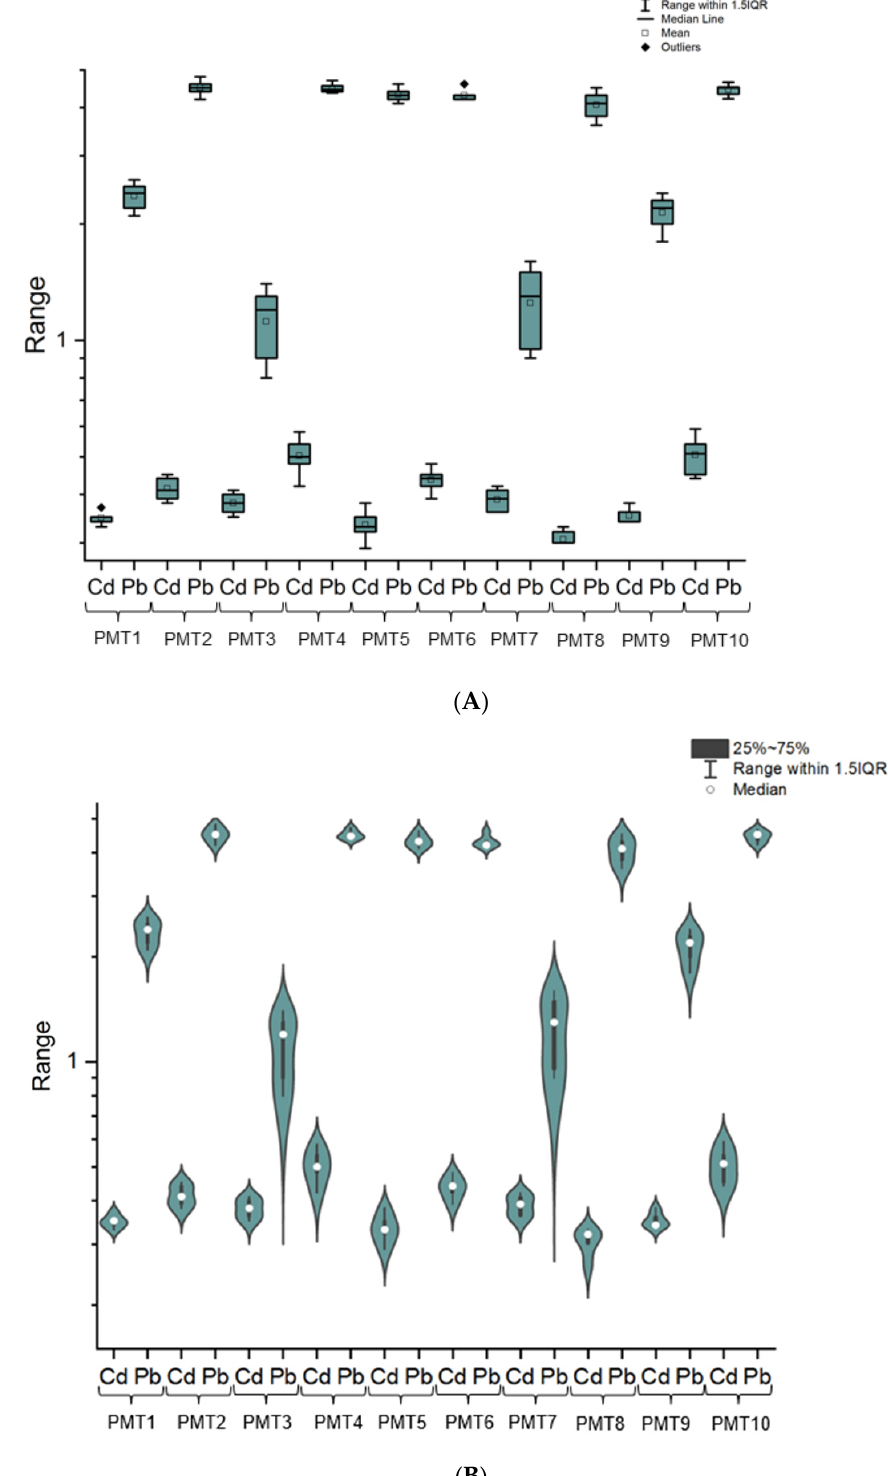
Figure 3. ( A ) The range of Cd and Pb impurities levels in all investigated herbal medicinal products with Mentha × piperita L., folium (PTM1–PTM10) as the plotbox (log scale). ( B ) The violin plot showing values of Cd and Pb impurities level (log scale) in all investigated herbal medicinal products with Mentha × piperita L., folium (PTM1–PTM10).